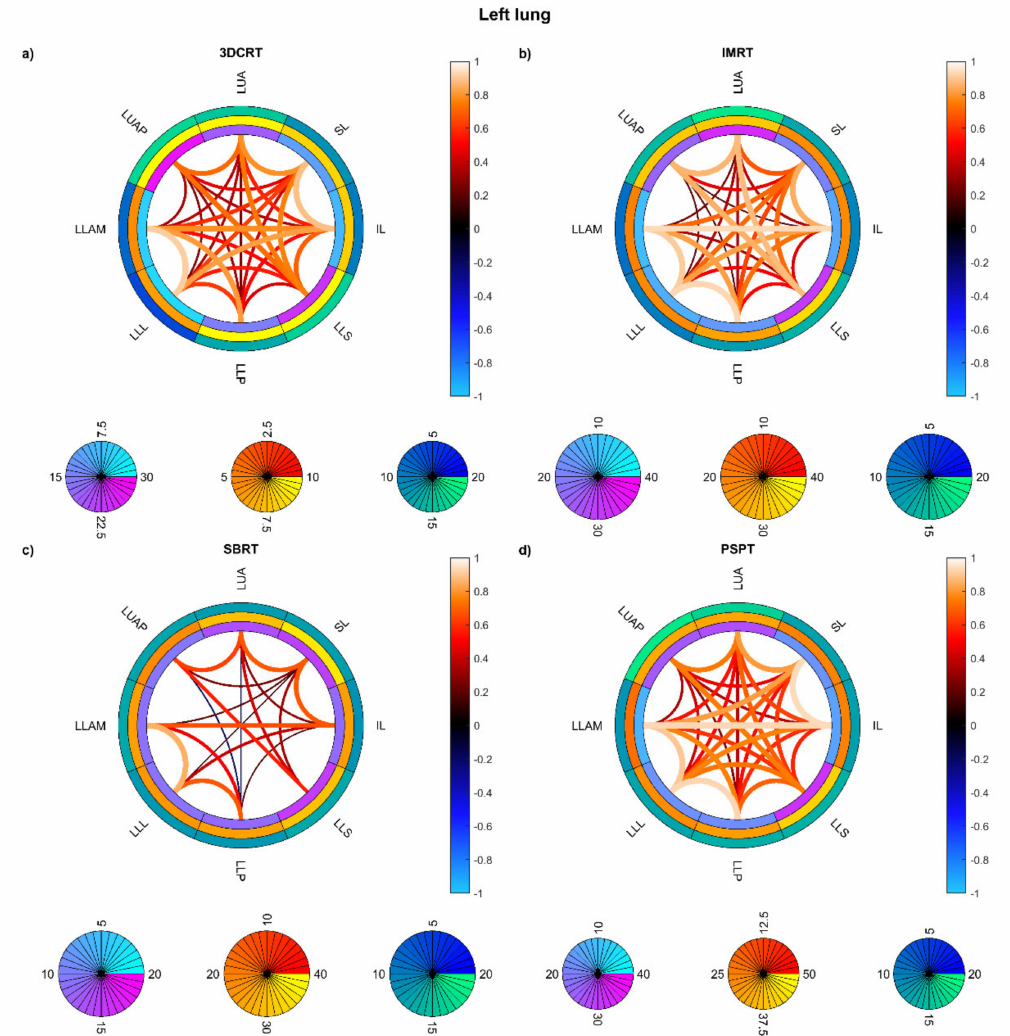
Figure 7. Connectograms in left lung substructures for the four groups of patients: Hodgkin lymphoma group—3DCRT ( a ), non-small cell lung cancer patients treated with intensity-modulated radiation therapy—IMRT ( b ), NSCLC patients treated with stereotactic body RT—SBRT ( c ), NSCLC patients treated with passive-scattering proton therapy—PSPT ( d ). The pairwise Spearman correlation coefficients between the mean biological effective dose (BED) values to the reported substructures are represented by the lines within the rings. From inside to outside, the rings represent the average of the substructure mean BEDs, standard deviation of the substructure mean BEDs, and average of the dose standard deviations within the substructure. BED is expressed in Gy. Abbreviations: LLAM: left lung lower lobe anteromedial; LLL: left lung lower lobe lateral; LLP: left lung lower lobe posterior; LLS: left lung lower lobe superior; IL: inferior lingula; SL: superior lingula; LUA: left lung upper lobe anterior; LUAP: left lung upper lobe